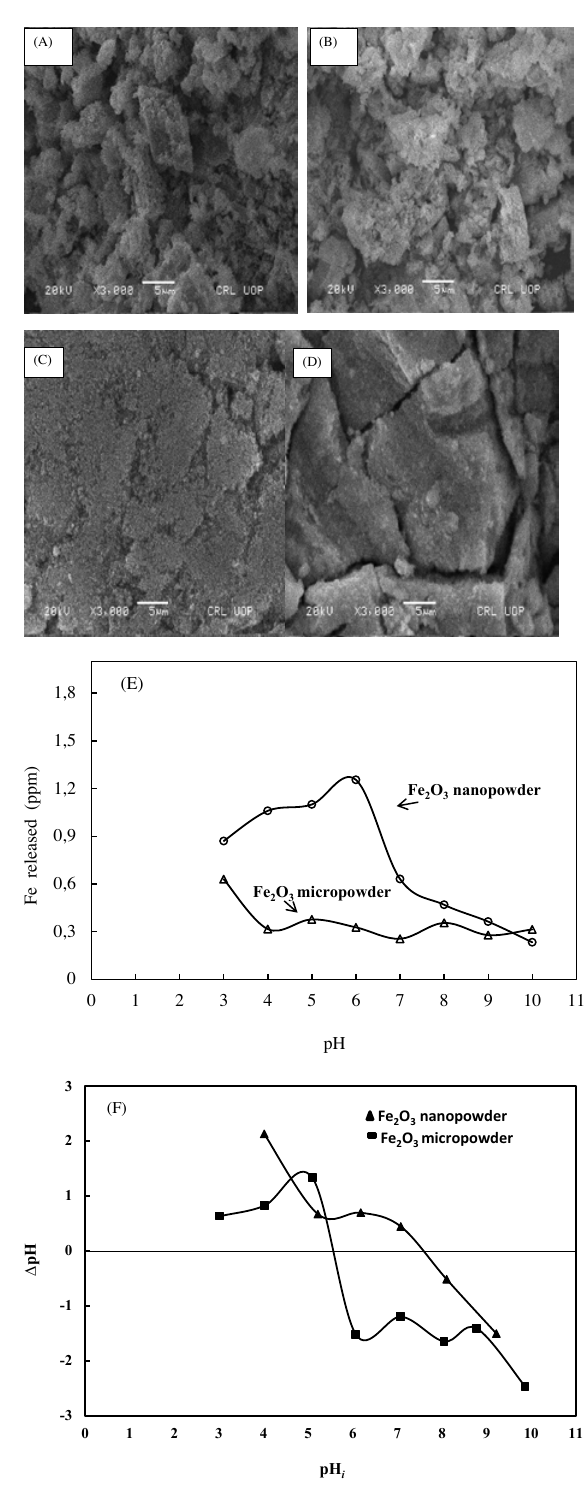
O (A) Before and (B) After 2 3 O beforeand (D) After 2 3